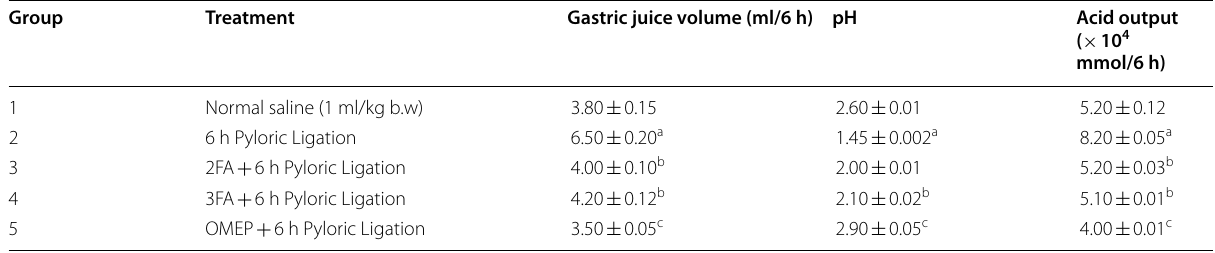
2FA 2 mg/kg Folic acid, 3FA 3 mg/kg Folic acid, OMEP omeprazole a P < 0.05, Pyloric ligation versus control group b P < 0.05, 2FA 6 h Pyloric Ligation versus 6 h Pyloric Ligation +